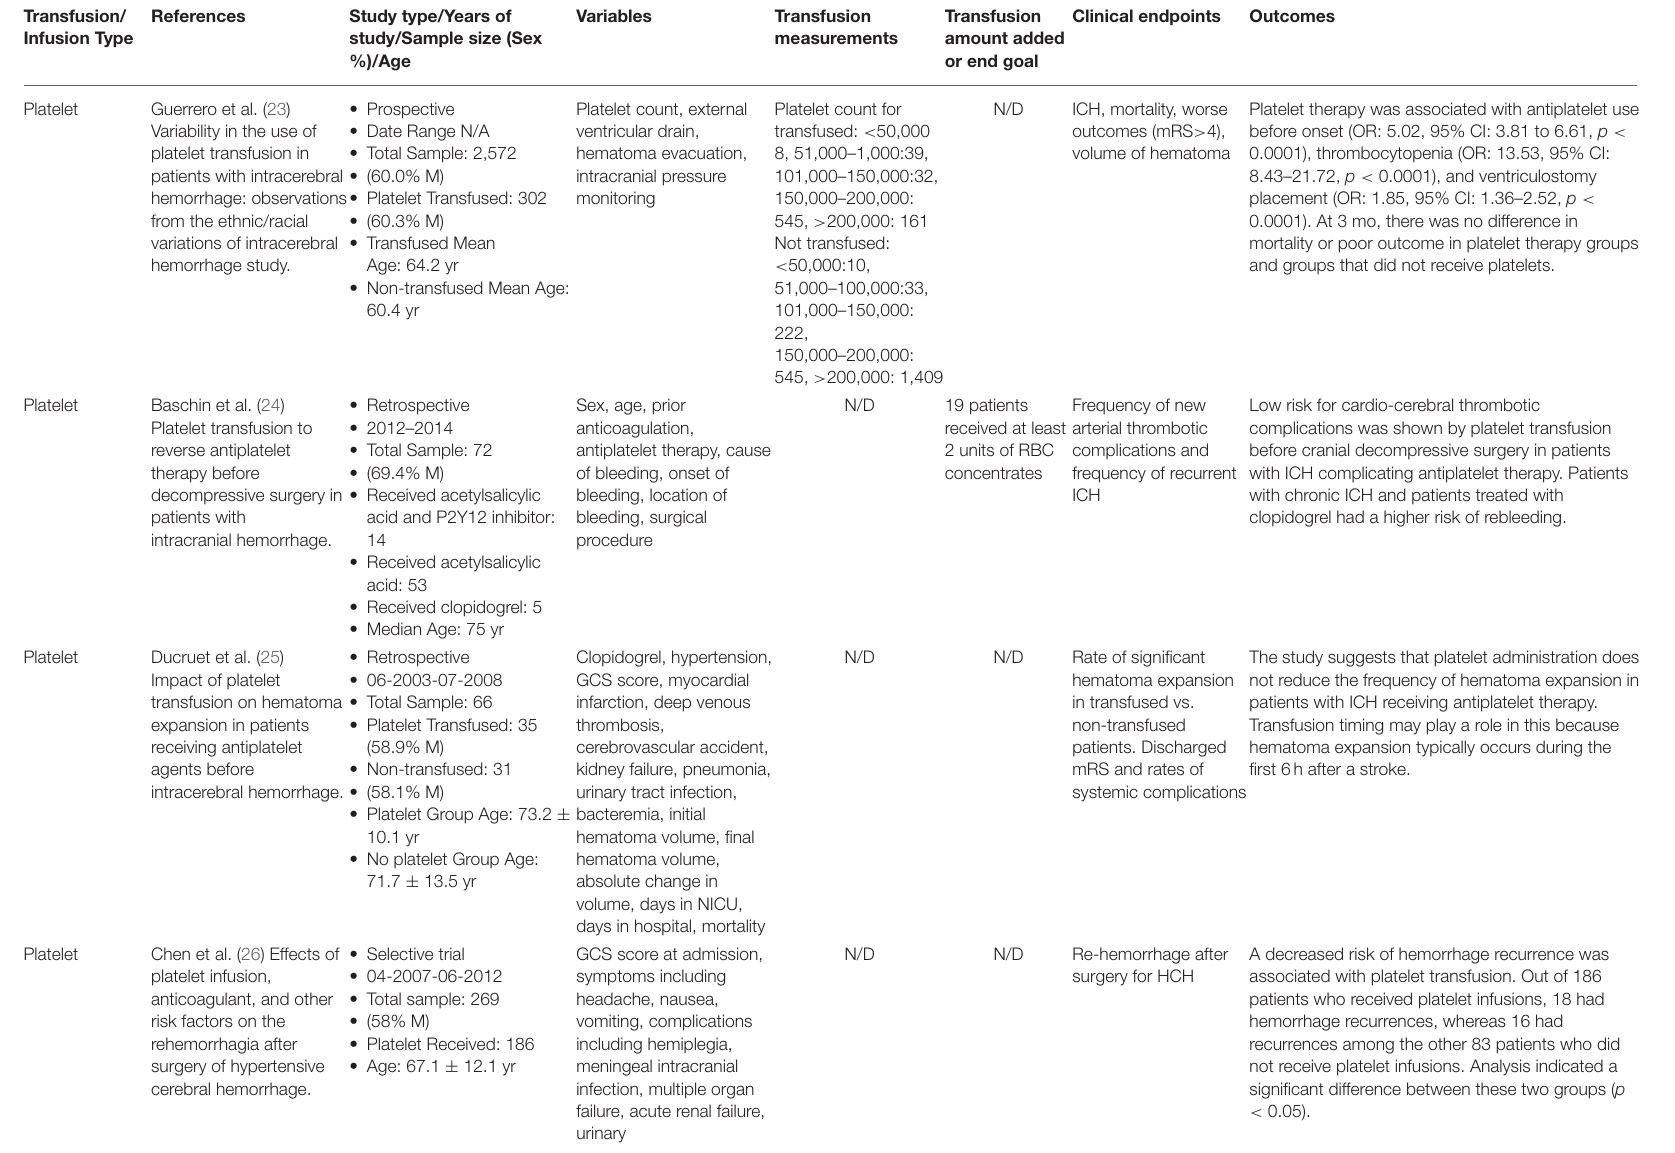
TABLE 1 | Summary of studies that have used blood product transfusion and tranexamic acid infusion therapy in patients with ICH. Transfusion/ Infusion Type